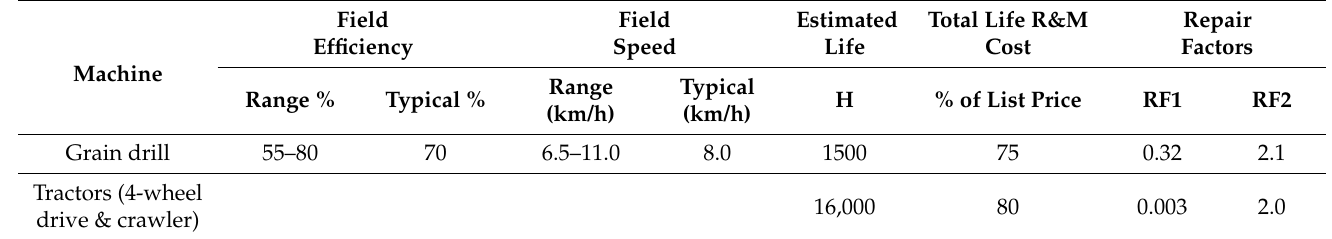
Table 1. Operational data and repair factors for conventional machine types [25].